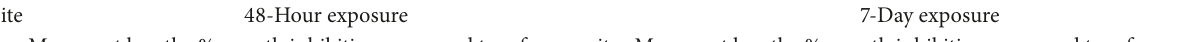
Table 3: The spatial variation of root lengths and percentage root growth inhibition of A. cepa bulbs exposed to water samples collected from study sites. Data are presented as mean ± SD. Results indicated by different superscript letters in each column are significantly different from each other (ANOVA, Tukey’s test, p < 0.05,